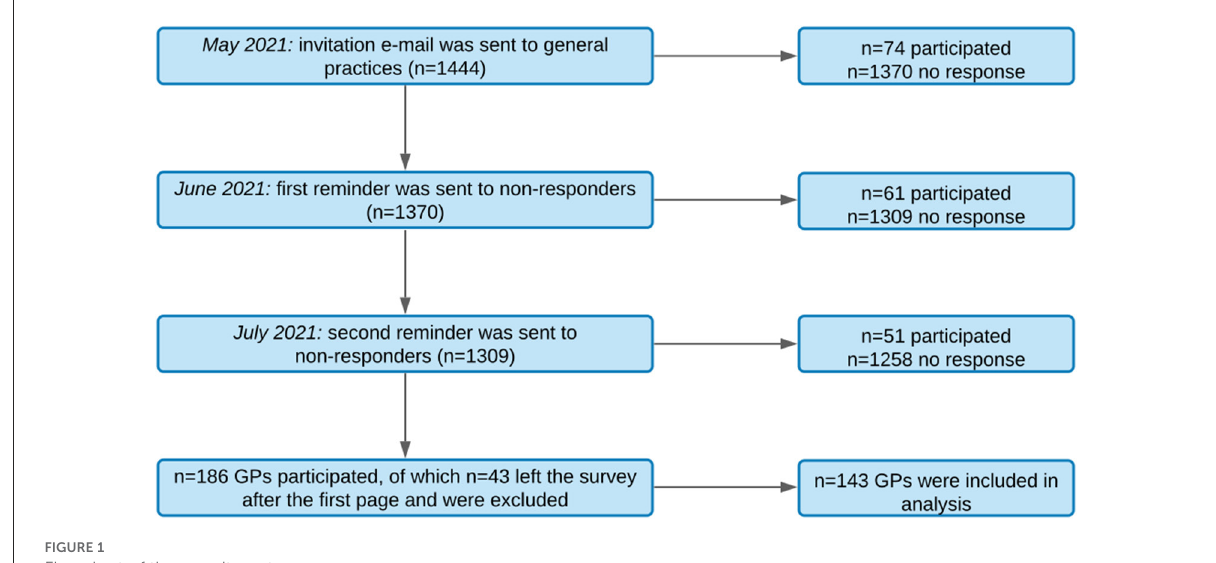
FIGURE1 Flowchart of the recruitment